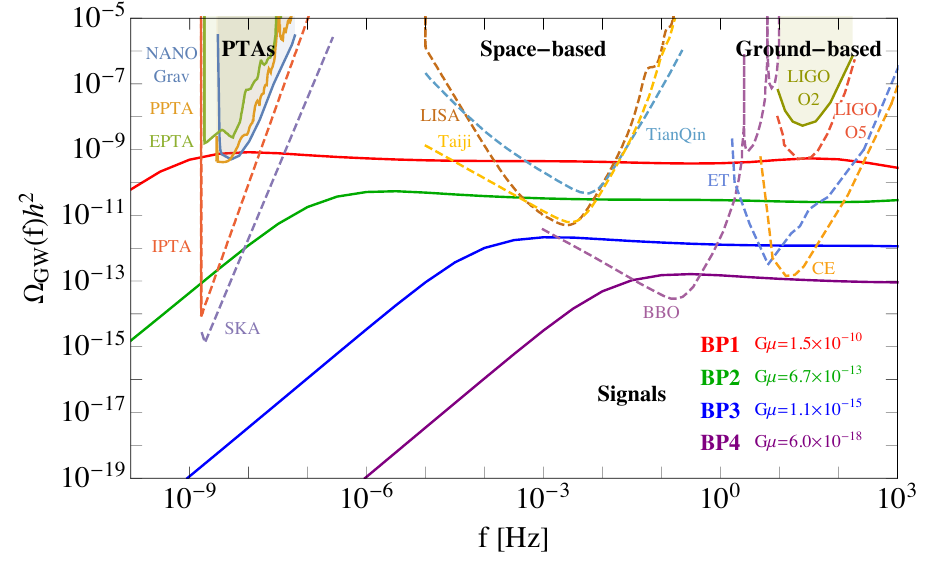
Figure 2 . The GW signals from the BPs in table 2, and the relevant sensitivity curves of current or future GW detectors. The existing constraints and projected sensitivities are shown as shaded regions and dashed lines,